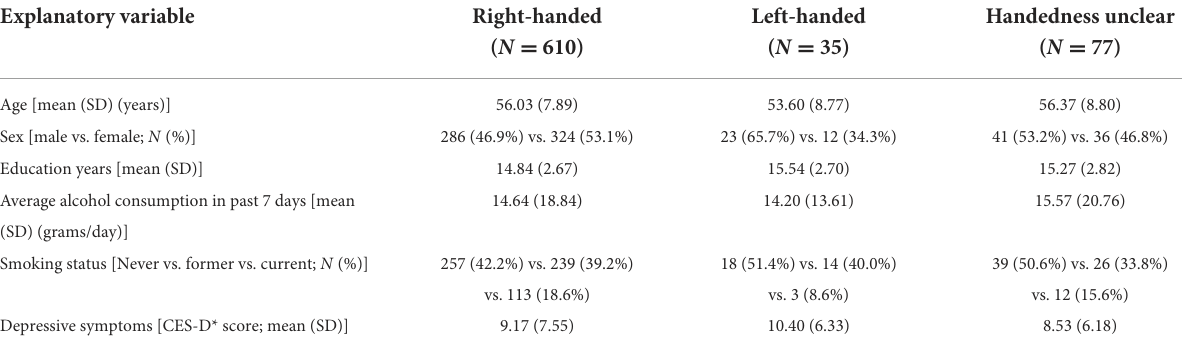
TABLE 2 Descriptive statistics for the participants stratified by